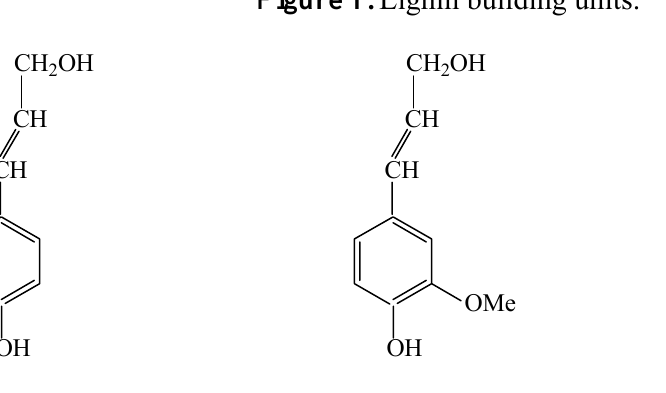
Figure 2. Aromatic aldehydes resulting from the lignin WAO